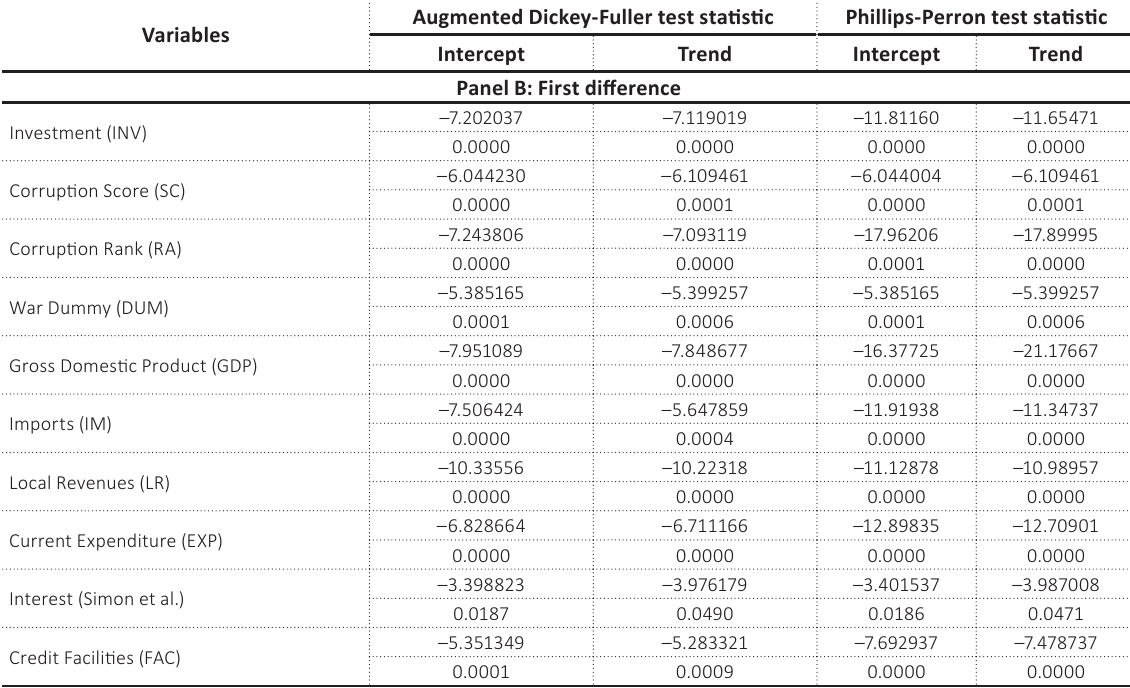
Table 2 (cont.). The results of augmented Dickey-Fuller and Phillips-Perron tests